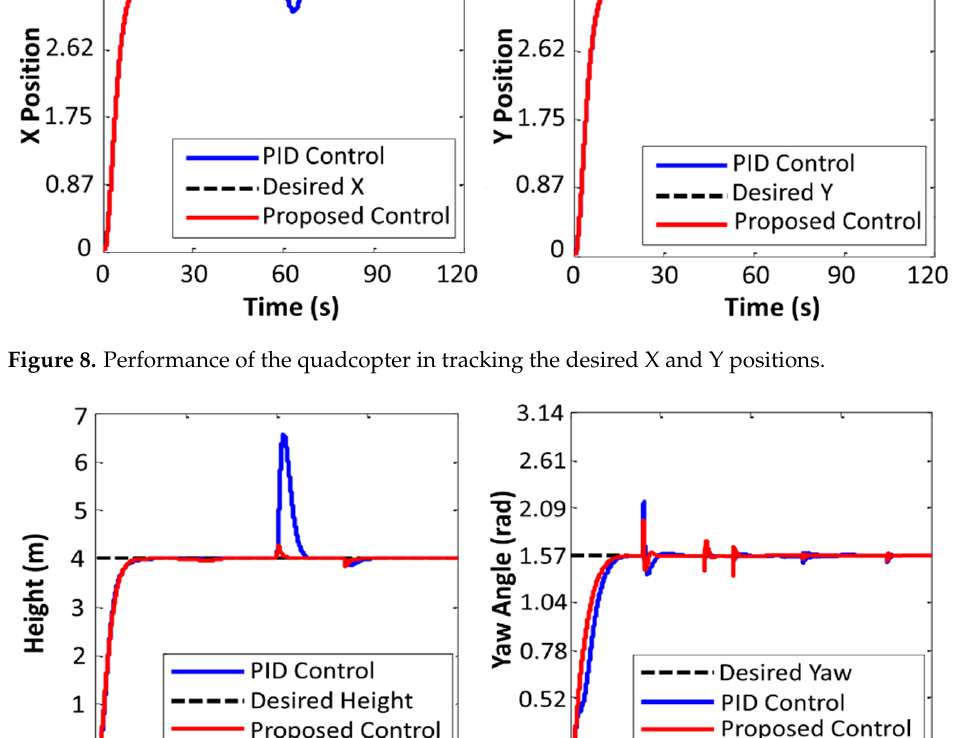
Figure 11. Variations in manipulated variables 𝑢 (cid:2869) and 𝑢 (cid:2870) . Figure 12. Variations in manipulated variables 𝑢 (cid:2871) and 𝑢 (cid:2872) . Figure 13. Variations in adaptive gain values of the X position PID controller.